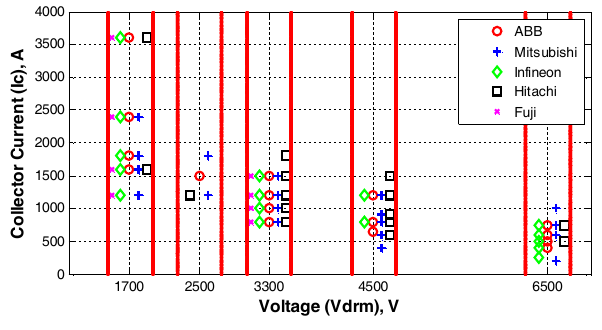
Figure 7. Commercially-available HV IGBT ratings.